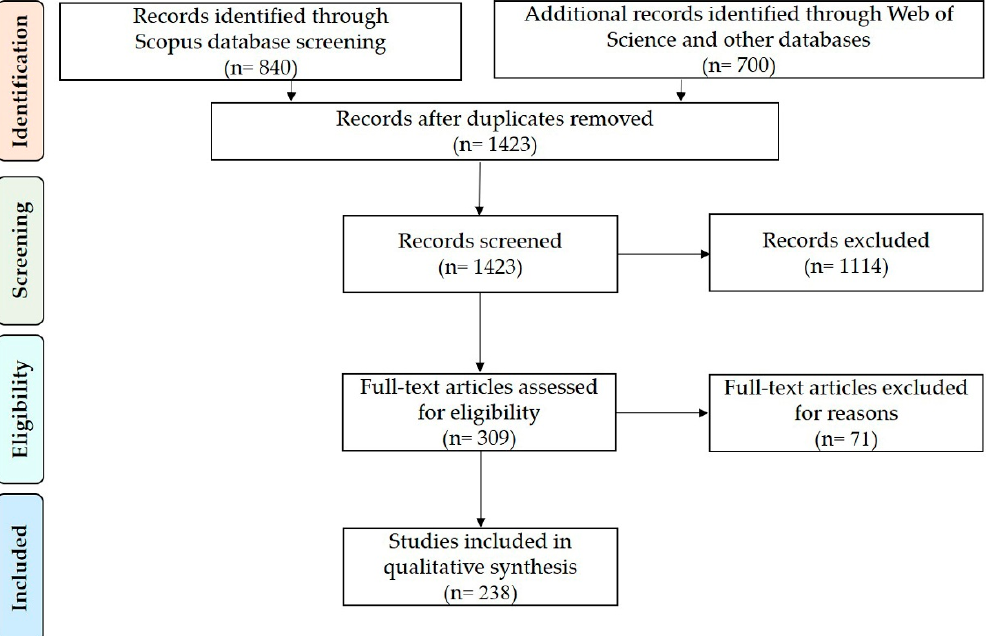
Figure 1. Workflow of selection procedure based on the PRISMA method.